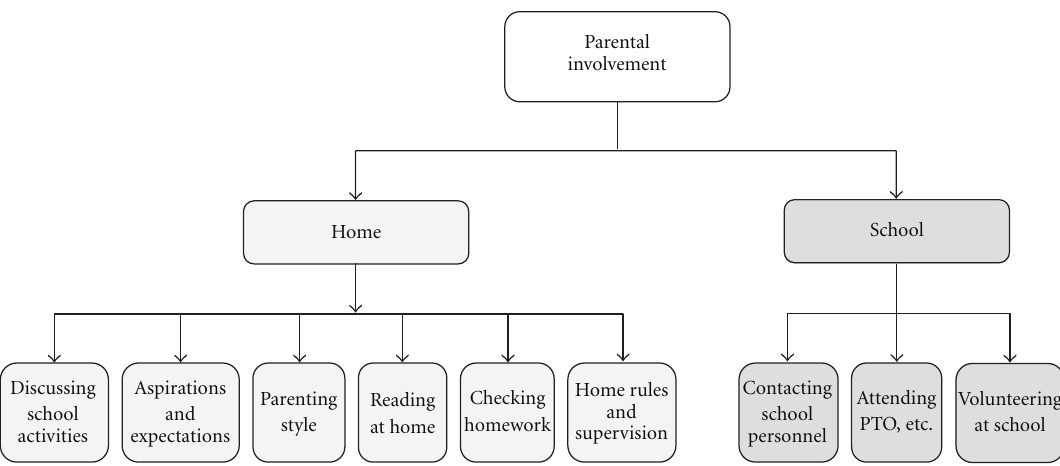
Figure 1: Prominent aspects of parental involvement enacted at home and at school.